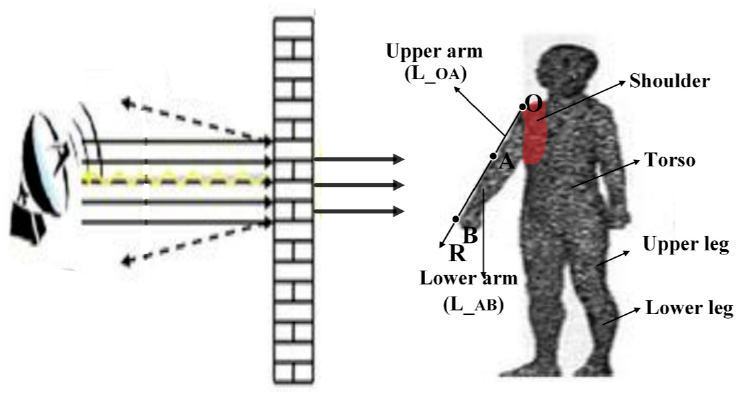
Figure 5. Geometry of the radar and moving human body structures.